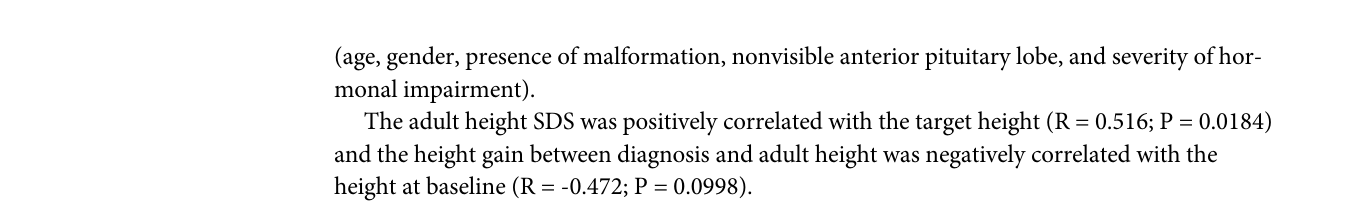
(age, gender, presence of malformation, nonvisible anterior pituitary lobe, and severity of hor- monal impairment). The adult height SDS was positively correlated with the target height (R = 0.516; P = 0.0184) and the height gain between diagnosis and adult height was negatively correlated with the height at baseline (R = -0.472; P = 0.0998).